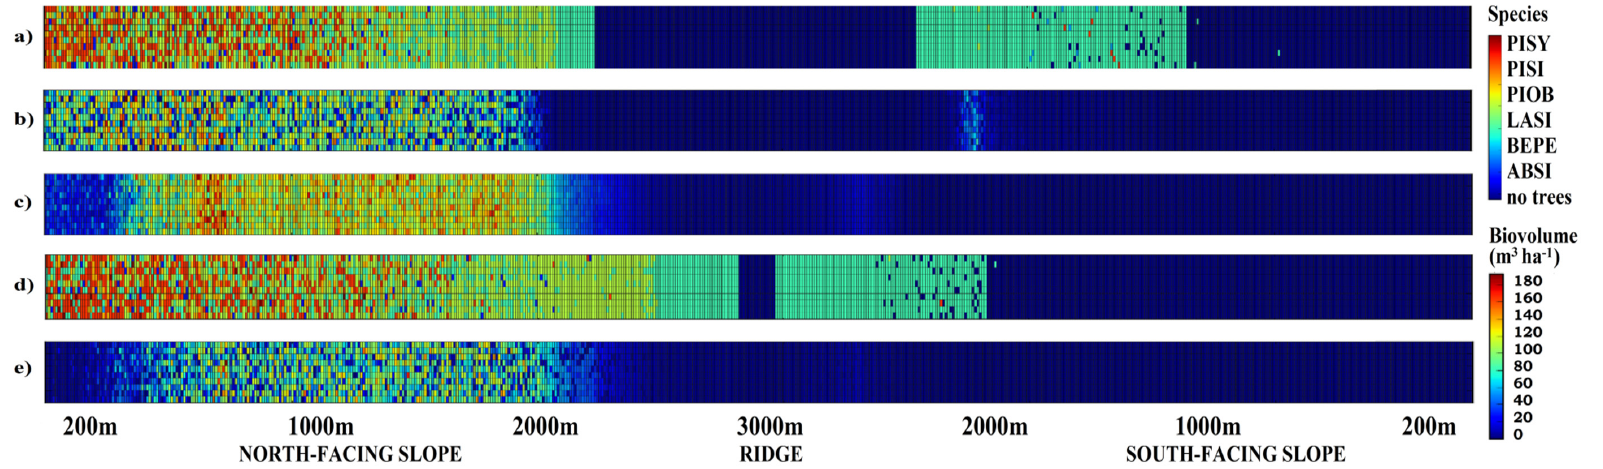
Figure 4. Simulated species and biovolume distribution along an idealized mountain with climate and edaphic conditions from southern Siberia: ( a ) species distribution under the historical (1960–1990) climate, no disturbance; ( b ) biovolume distribution under the historical climate, no disturbance; ( c ) species distribution from the year 2100 under a warming scenario, no disturbance; ( d ) species distribution from the year 2100 under a warming scenario, drought ‐ triggered fire; ( e ) biovolume distribution from the year 2100 under a warming scenario, drought ‐ triggered fire. Larch is represented by teal color, and although many plots appear to have larch along the south slope, the wood biovolume of these sparse saplings is quite small and they do not sequester or store much carbon. Each grid cell represents one 10 m × 10 m plot. The top color bar represents species type in (a,c,d). The lower color bar represents biovolume in (b,e) in m 3 ∙ ha − 1 .